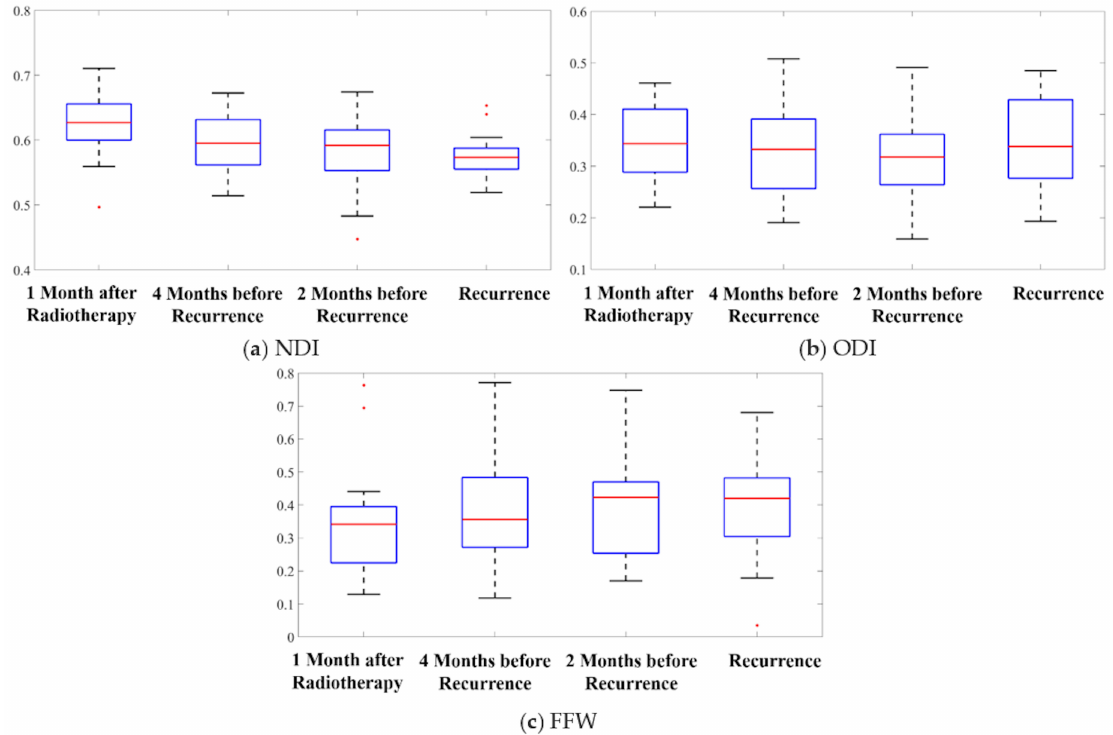
Figure 2. Box plots of the mean values of ( a ) neurite density index (NDI), ( b ) orientation dispersion index (ODI), and ( c ) free water fraction [FWF] within recurrent tumor regions over the four time points. The five bars in the box plots indicate, from bottom to top, the minimum, first quartile, median, third quartile, and the maximum. The red dots indicate